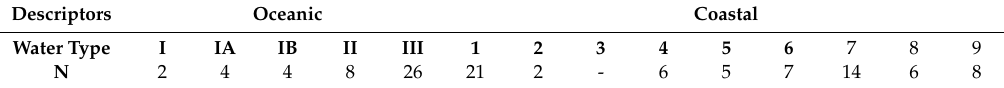
Table 3. Number of observations (N) classified into a Jerlov water type for the 113 stations with a .